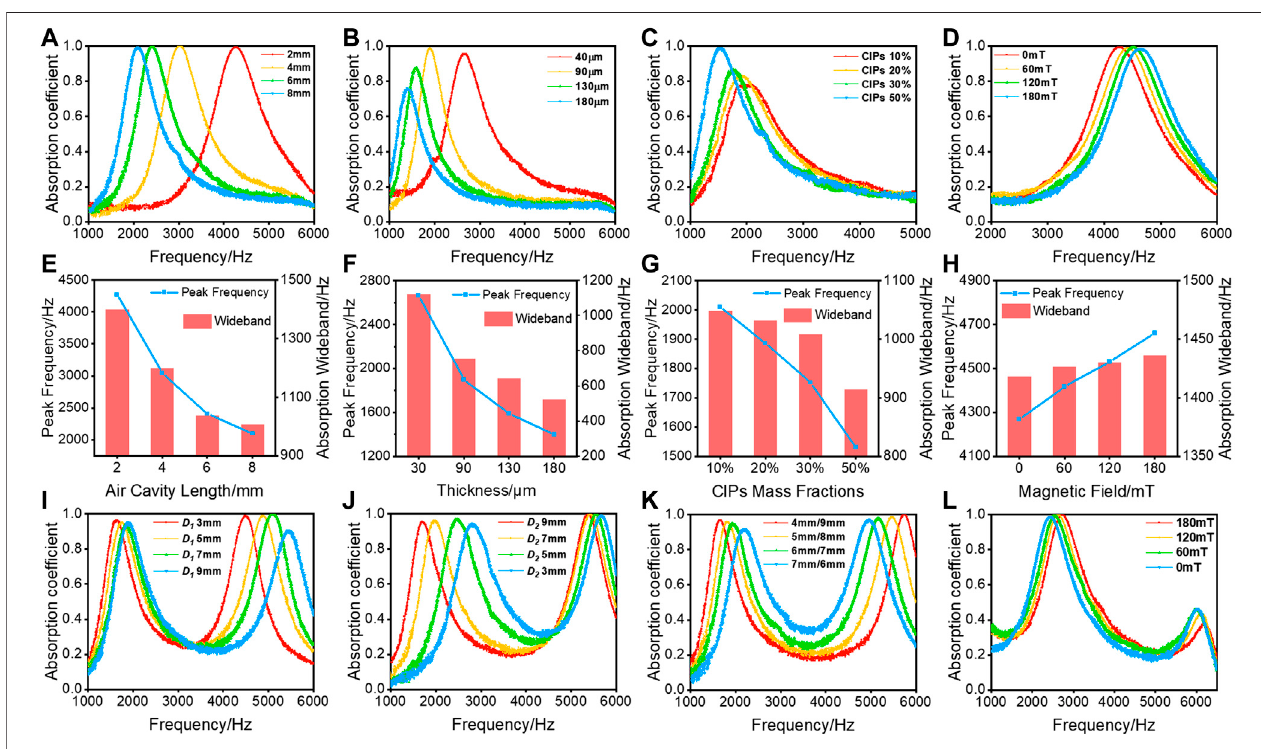
FIGURE 5 | The in fl uences of the air cavity length behind the membrane (A) , the thickness of the membrane (B) , mass fractions of CIPs (C) , the magnetic fi eld (D) onthesoundabsorptioncurves.Thepeakfrequencyandthesoundabsorptionwidebandcorrespondingtotheaboveimage (E – H) .Thesoundabsorptioncurvesofthe double-layer membrane structure with the varied length of the air cavity (I – K) . In fl uences of the magnetic fi eld on the double-layer membrane structure (L)